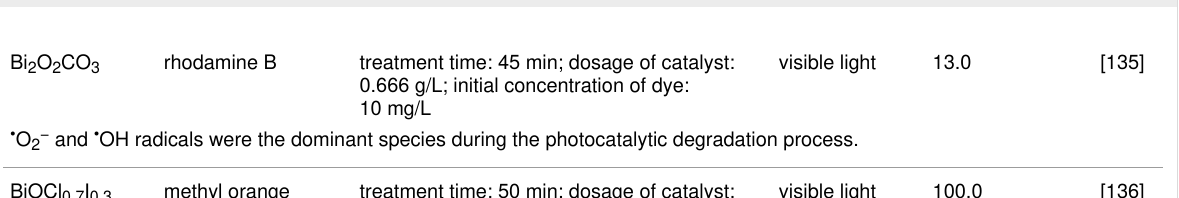
Table 5: Undoped Bi-based nanostructured photocatalysts for remediation of dye pollution. (continued)